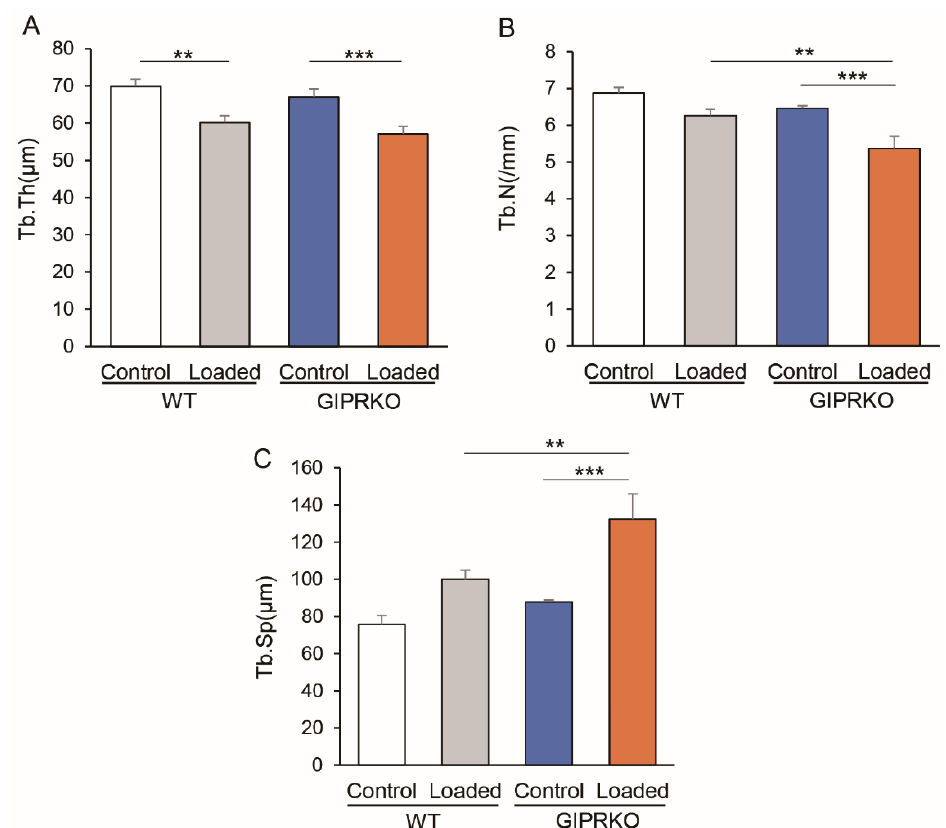
Figure 5. Measurement of trabecular structure of WT and GIPRKO. The mean trabecular thickness (Tb.Th.) was determined from the local thickness at each representative bone. The trabecular separation (Tb.Sp.) was calculated by calculating the direct thickness to the non-bone sections of the 3D image. ( A ) Comparison of Tb.Th. of the M1 inter-root septum (** p < 0.01, *** p < 0.001). ( B ) Comparison of the number of trabeculae (** p < 0.01, *** p < 0.001). ( C ) Comparison of the Tb.Sp. (** p < 0.01, *** p < 0.001) (WT: n = 5, GIPRKO: n =